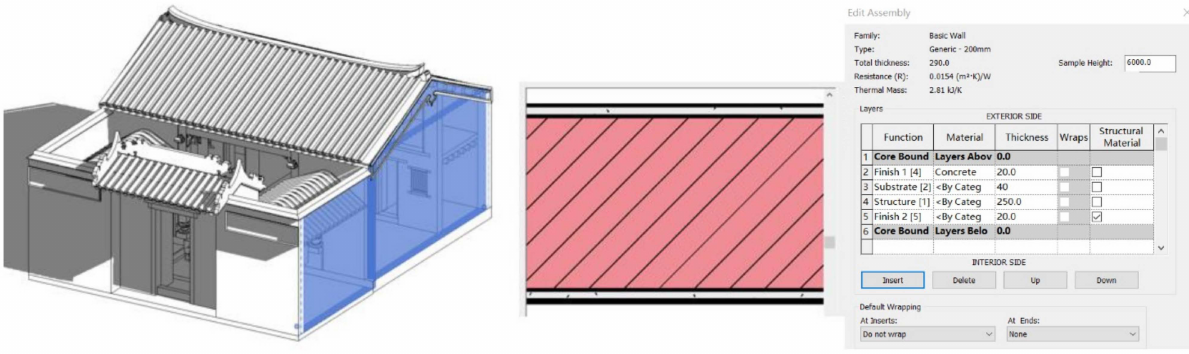
Figure 13. Digital expression of the wall of Sisheng Hall and the function of